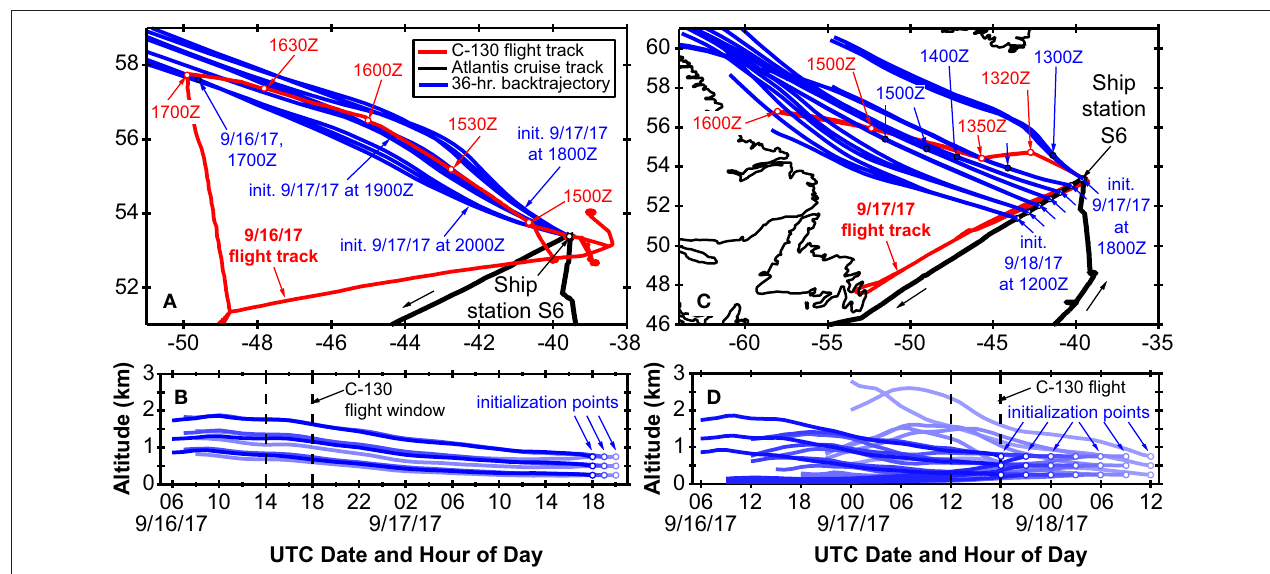
FIGURE 14 | Summary of the Lagrangian sample experiment during NAAMES 3. Red lines in (a,b) denote the C-130 flight tracks from 16 to 17 September, while the black line denotes the R/V Atlantis cruise track in the vicinity of Station S6 (NAAMES 3). Blue lines in all panels show NOAA HYSPLIT air mass back trajectories initialized at the ship location (Station S6 on September 16th and at seven locations along the cruise track on September 17–18th). Red open circles show the UTC flight time for low-altitude sampling, while the filled blue circles on the HYPSLIT trajectories indicate the portion of the back trajectory that is spatially contemporaneous with the flight track. The vertical components of the back trajectories are shown in (b,d) .